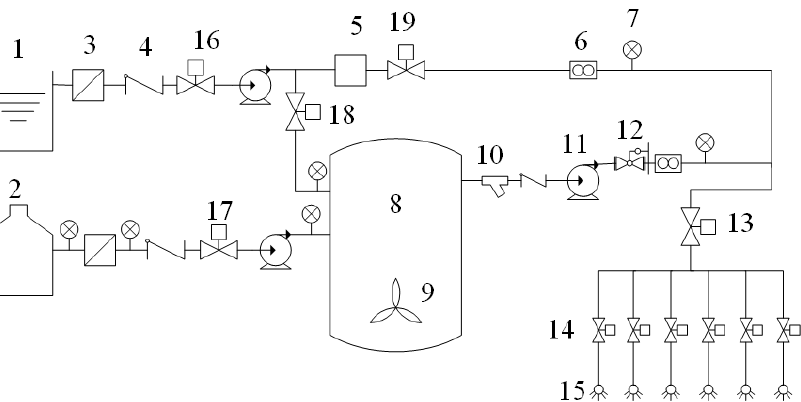
Figure 1. Structure diagram of precision fertilization control system: 1. Reservoir; 2. Fertilizer tank; 3. Filter; 4. One-way valve; 5. Pressure regulator; 6. Flow sensor; 7. Pressure gauge; 8. Mixing